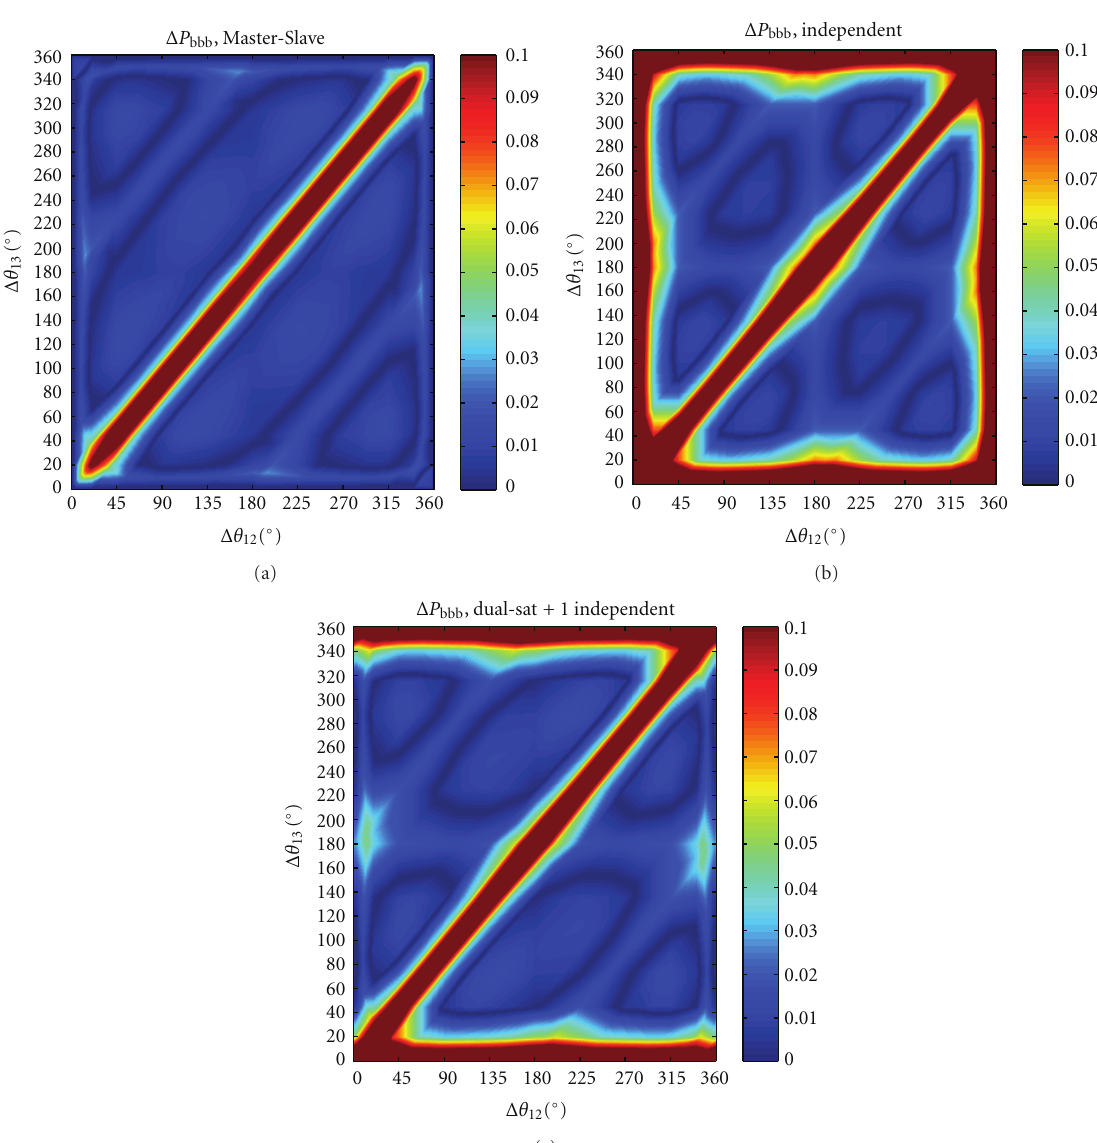
Figure 10: Performance comparison for three-satellite modelling between Master-Slave method (a), independent modelling (b), and a two- satellite model + one independent satellite (c). The figures show the di ff erence between measured and resimulated “bad bad bad” state probability ( Δ P bbb ) for di ff erent azimuth angle separations ( θ 12 and θ 13 ) of two slave satellites. The elevation angles are φ 1 = φ 2 = φ 3 = 15 ◦